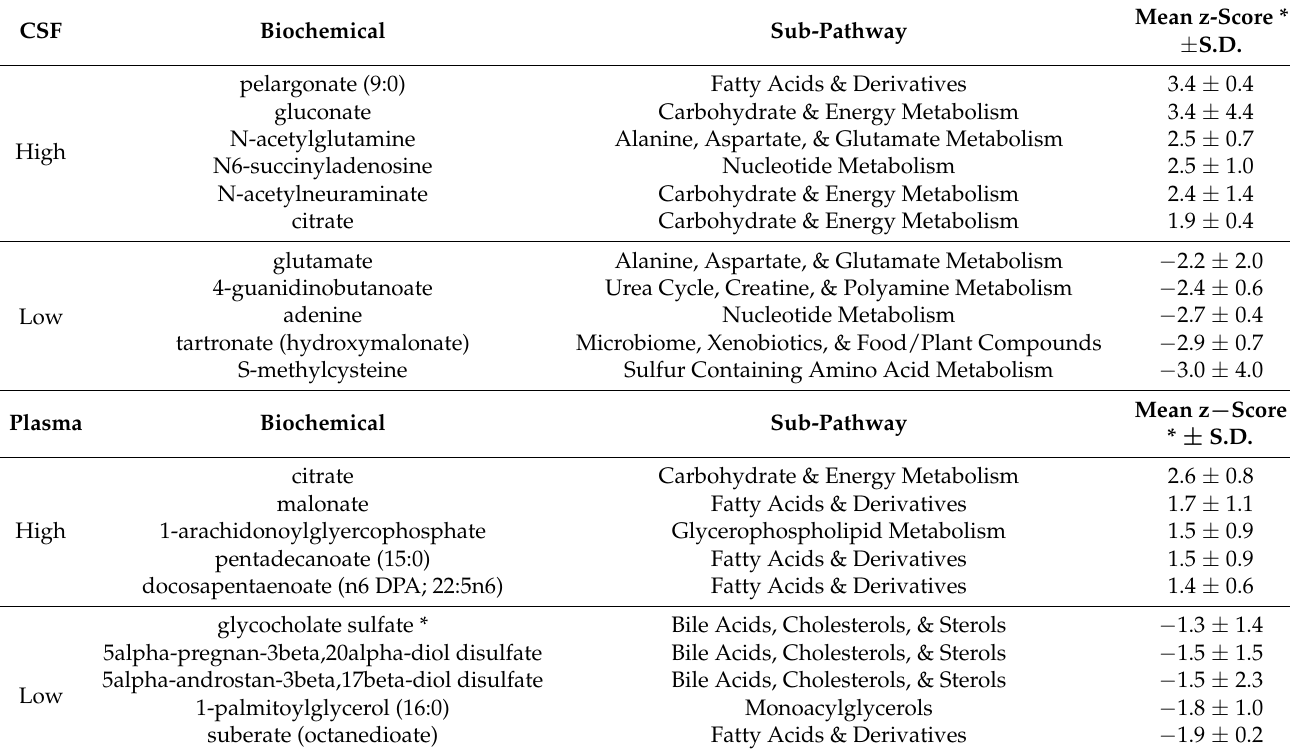
Table 1. Significantly Altered Metabolites in Plasma and Cerebrospinal Fluid in Patients with SLC13A5